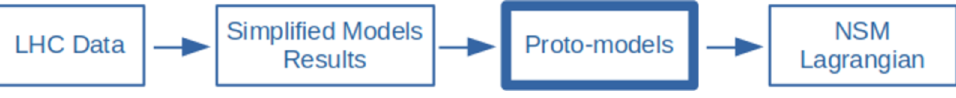
Figure 1 . Overall strategy of how we may envisage to construct an NSM from LHC data: the outcomes of specific searches, which are communicated via simplified model results, are used to construct proto-models. These may be scrutinized in dedicated analyses and eventually help to infer the NSM; see also [4, 12,